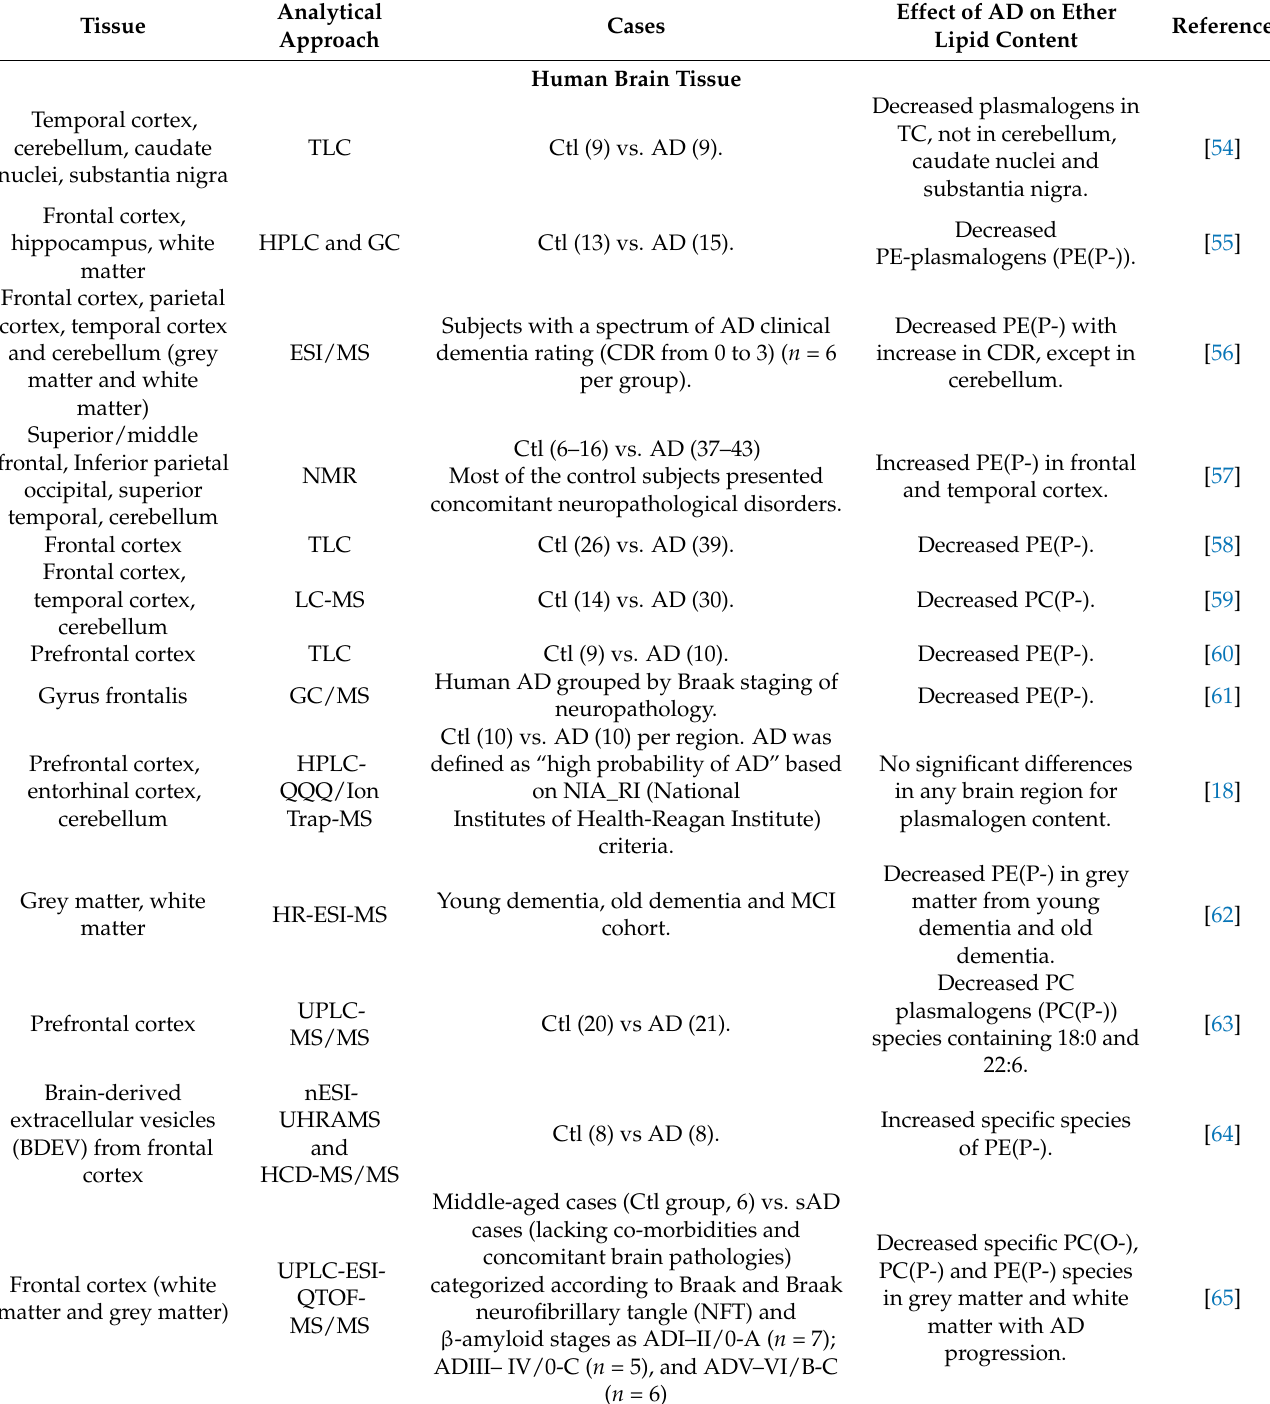
Table 1. Updated list of studies analyzing ether lipid content in Alzheimer’s disease